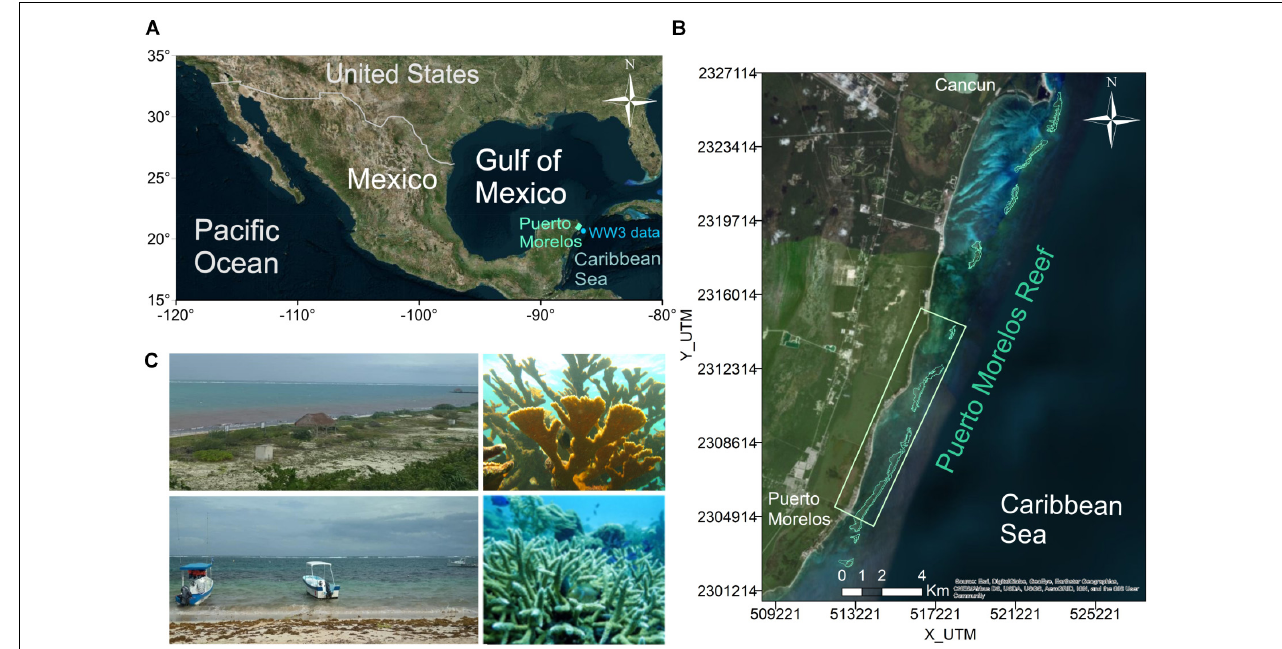
FIGURE 1 | Study area: (A) General location. (B) Detail of the study area. (C) Coral species and beach views in Puerto